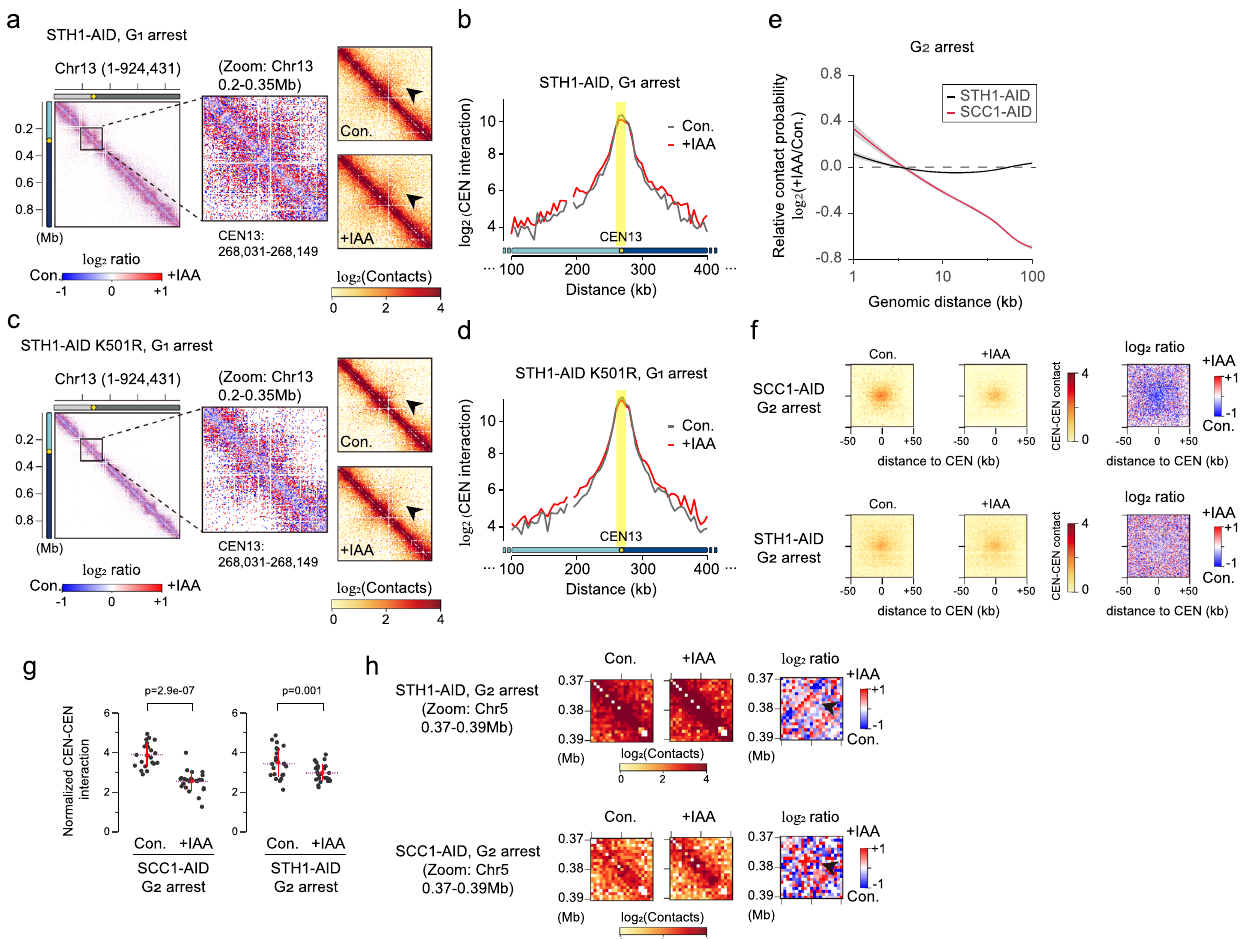
Fig. 4 Sth1p has functions distinct from those of Scc1p in regulating 3D genome organization, except in the case of centromere clustering at G 2 phase. a Contact map (1-kb resolution) of chromosome 13 for STH1-AID strain at G 1 phase. The black arrow indicates peri-centromeric interactions. b The distributions of intra-chromosomal contacts with the centromere locus on chromosome 13 in STH1-AID control (gray line) and + IAA (red line) samples at G 1 phase. The normalized contact value of the 5-kb-scale bin containing the centromere position was used for the calculation. The yellow dots indicate the point centromere of the chromosome. The centromere locus is highlighted in the yellow box. c Contact map (1-kb resolution) of chromosome 13 in STH1- AID K501R strain at G 1 phase. The black arrow indicates peri-centromeric interactions. d Same as described for b , but in the STH1-AID K501R control (gray line) and + IAA sample (red line). e Log 2 ratio of the average contact probability (CP) along genomic distance between control (Con.) and IAA-treated ( + IAA) samples of SCC1-AID (red line) and STH1-AID (black line) strains at G 2 phase. The gray shadow shows display con fi dence interval around smooth. (Data deposited under accession number GSM2417297 was used for the SCC1-AID dataset). f Average matrices with 1-kb resolution showing inter CEN- CEN interactions (left panels) and their log2 ratios (right panels) in SCC1-AID (top) and STH1-AID (bottom) strains at G 2 phase. g The central 5 × 5 of the 1-kb scaled bins (n = 25) were used for plotting. The red line means standard deviation and pink dashed line represents the mean value. Statistical signi fi cance was measured using a one-sided Wilcoxon rank-sum test. h Zoom-in contact maps showing a narrow region (0.37 – 0.39 Mb) on chromosome 5 in STH1-AID (top) and SCC1-AID (bottom) strains at G 2